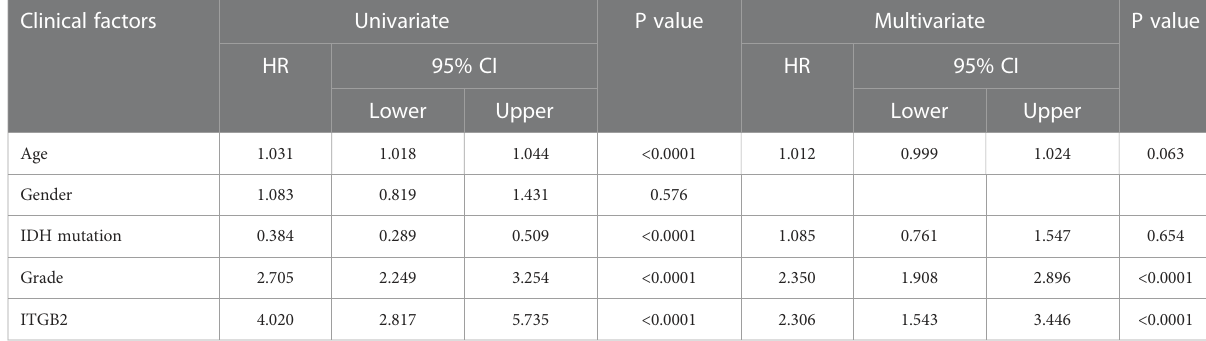
TABLE 1 Univariate and multivariate Cox analysis in CGGA RNA-seq